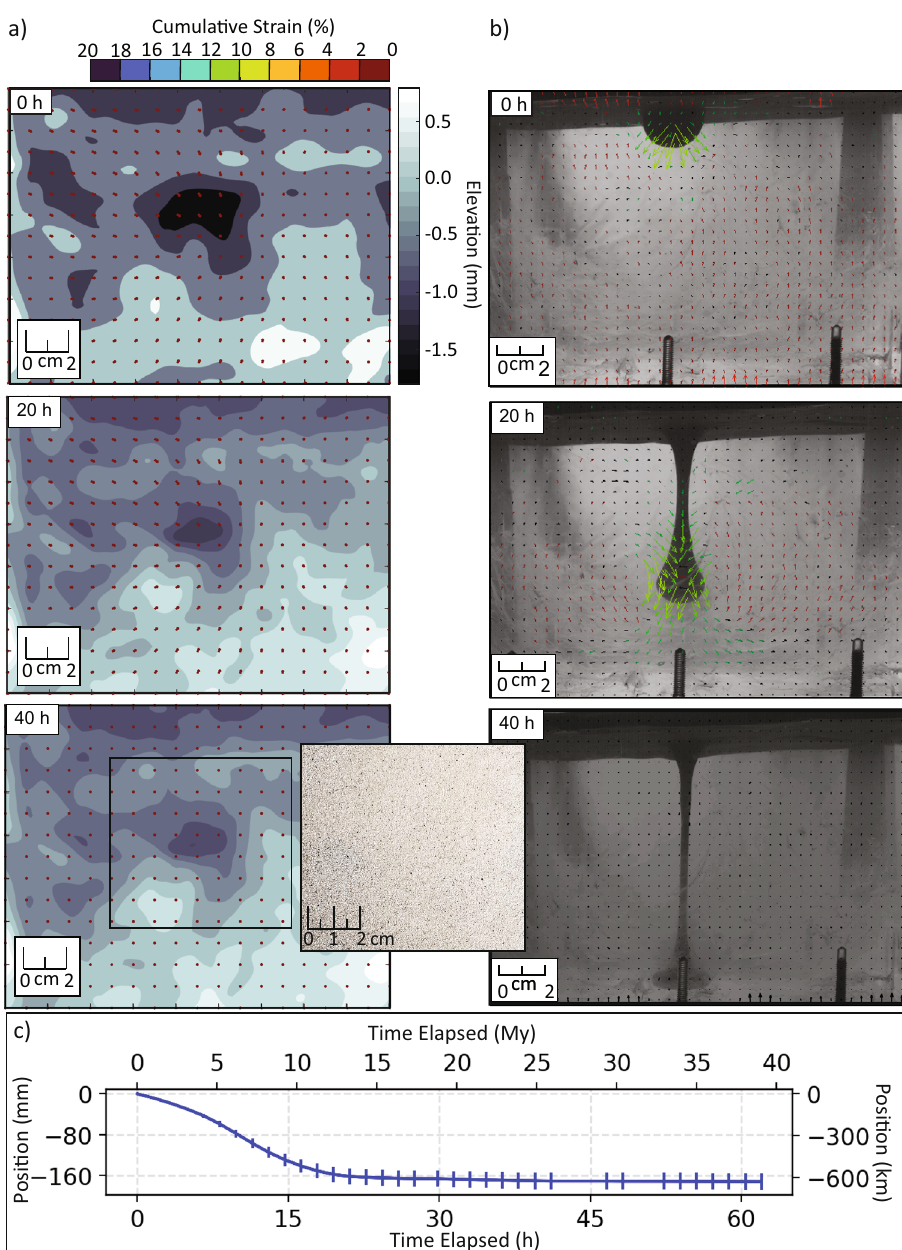
Fig. 3 Evolution of EXP-2. a Plan view evolution of topography and cumulative strain over 40 h. Red strain arrows indicate some accumulation of strain at 0 h. Photograph of the surface at 40 h depicts no convergence in the crust. A basin ~0.5 mm deep is illustrated at 40 h. b Evolution of drip (sideview) beneath the surface with downward green displacement vectors. Red vectors indicate upward displacement of the PDMS. c Progression of drip beneath the base of the mantle lithosphere. The drip sank in a continuous path and touched the bottom of the box at ~25